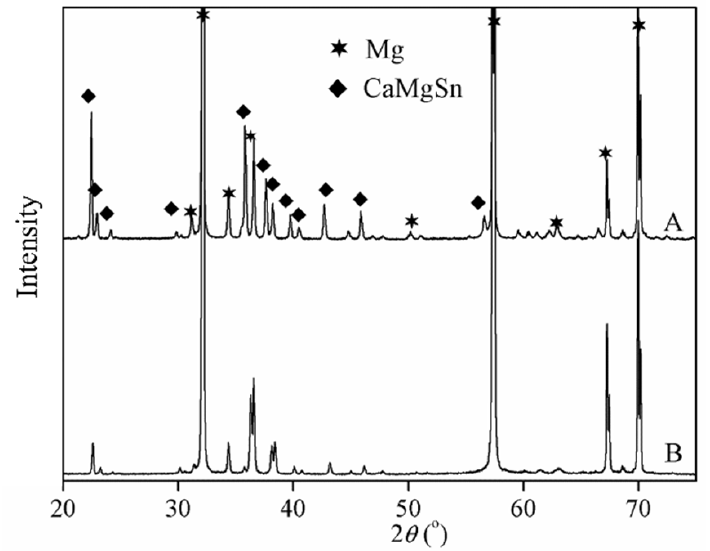
Figure 1. XRD patterns of as-cast ( A ) and extruded ( B ) Mg–CaMgSn master alloy. Typical microstructures of as-cast and extruded Mg–3CaMgSn master alloy samples are presented in Figure 2. For the as-cast sample in Figure 2a, the second phases were distributed along the grain boundaries, and some bright particles were found among the eutectic phases. According to the EDS result of point A, this phase was with Ca and Sn, and the atomic ratio of Sn to Ca was 0.8, close to 1, inferring it was the CaMgSn second phase. In Figure 2b, after extrusion, the CaMgSn second phases were broken into small pieces and dispersedly distributed along the extrusion direction. The length of the broken particles was approximately 10–20 µ m, and the thickness was approximately 2–5 µ